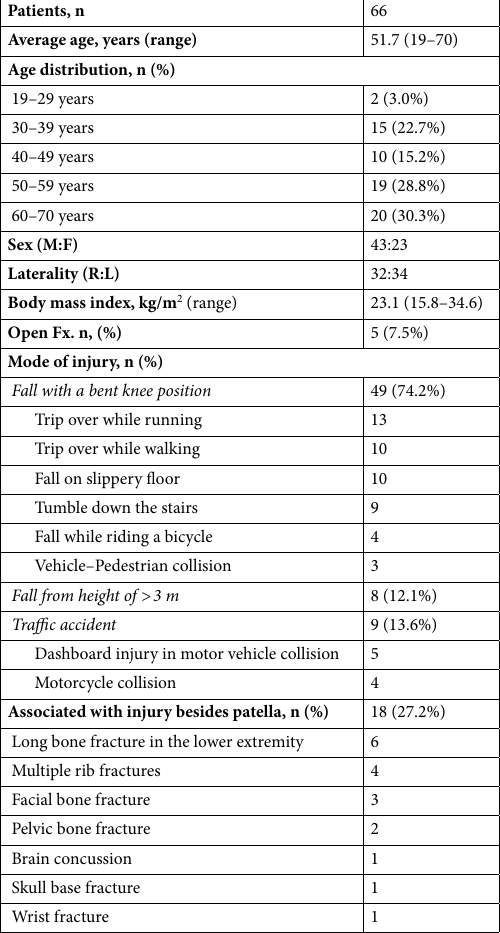
Table 1. Patient demographic and fracture characteristics. F female, Fx fracture, L left, M male, R